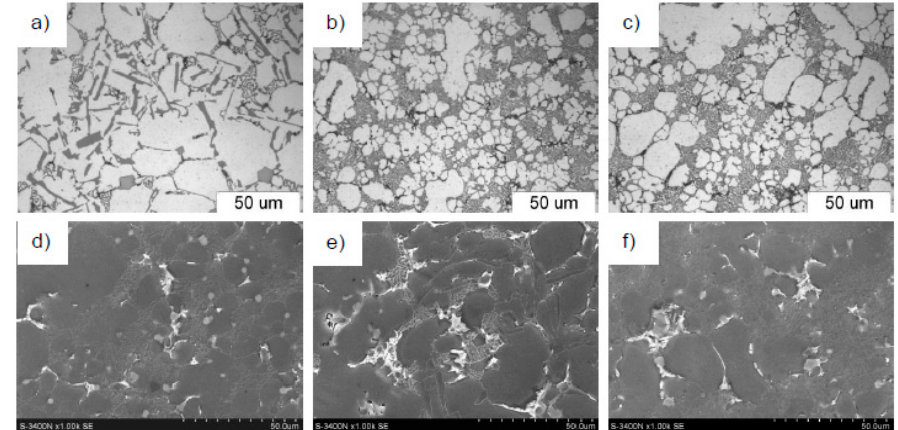
Figure 3. Microstructure of alloy AlSi10Mg0.5Mn0.5: ( a , d ) in initial condition (with various magnifications); ( b , e ) with addition of powder-1; ( c , f ) with addition of powder-2; ( a – c —light microscope Olympus GX-71, d – f —scanning electron microscope Hitachi